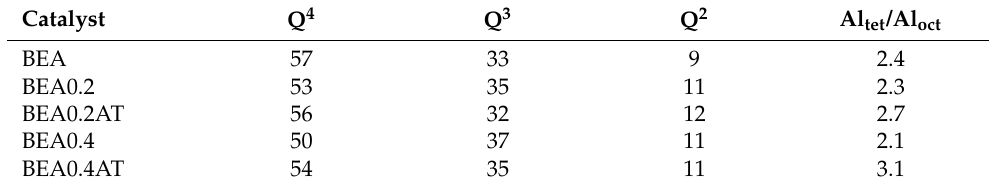
Table 2. Relative amount (expressed in %) of Q n (n = 4–2) sites ascertained from 29 SiMAS-NMR and tetrahedral-to-octahedral Al ratio (Al tet /Al oct ) determined from 27 Al MAS-NMR. Catalyst Q 4 Q